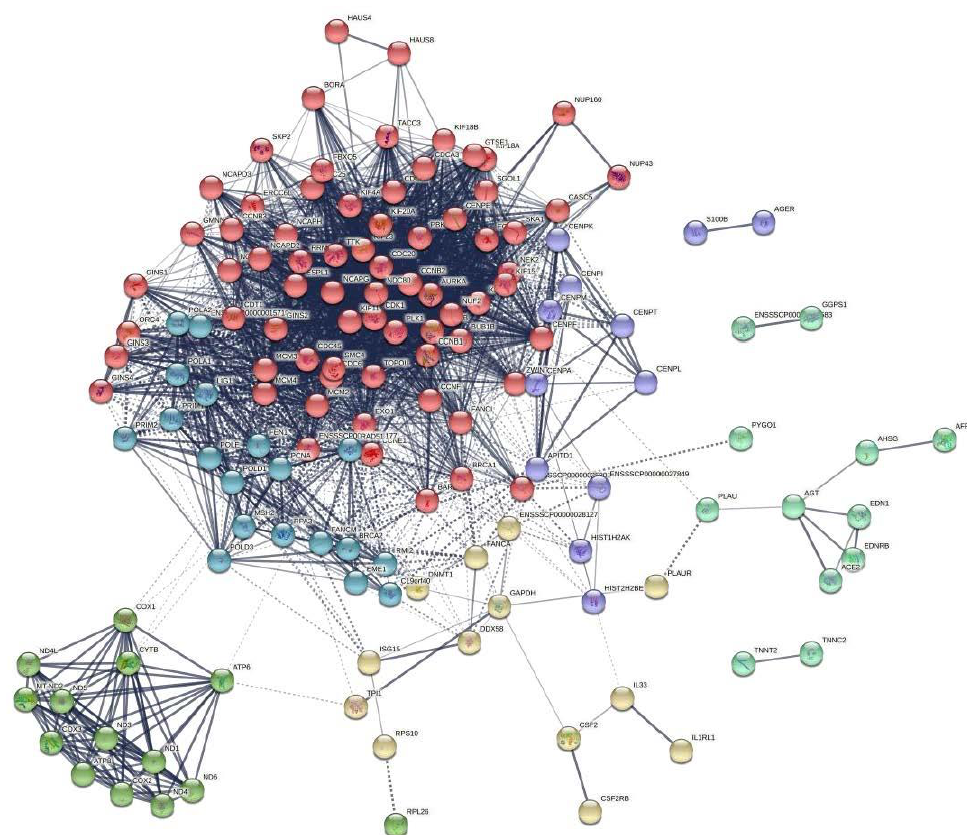
Figure 8. The protein–protein interaction (PPI) network analysis was based on the DEGs after CDCA treatment. The network was set up according to the string online tool. Nodes represent genes, and the weights of the edges represent how specifically two genes are associated together. Of the six clusters (represented by six colors), the red cluster includes genes related to the cell cycle, and the lime green cluster includes genes related to mitochondrial biogenesis. The detailed information for node attributes, node degree, and clusters of the PPI network is shown in Tables S3–S5, respectively.